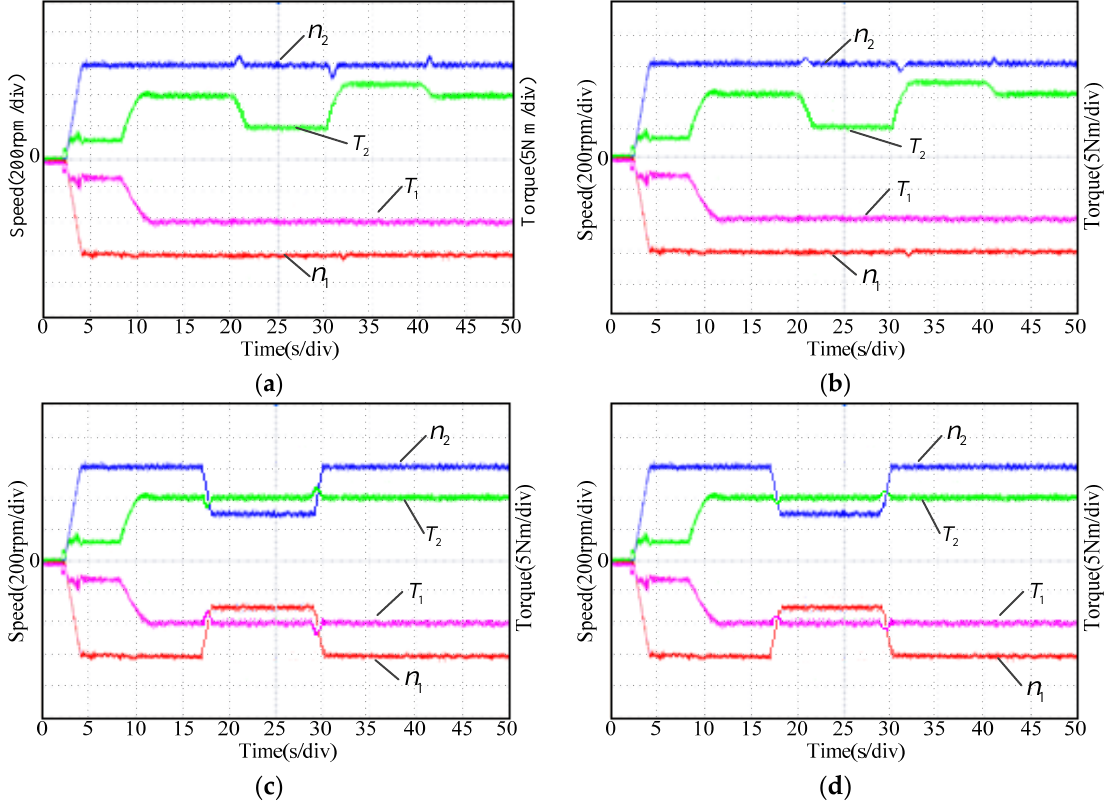
Figure 9. The dynamic performance of the system under PI or SMC speed control. ( a ) Torque and speed response based on PI speed control (only load 2 changes); ( b ) torque and speed response based on SMC speed control (only load 2 changes); ( c ) torque and speed response based on PI speed control (the speed command changes); and ( d ) torque and speed response based on SMC speed control (the speed command changes).